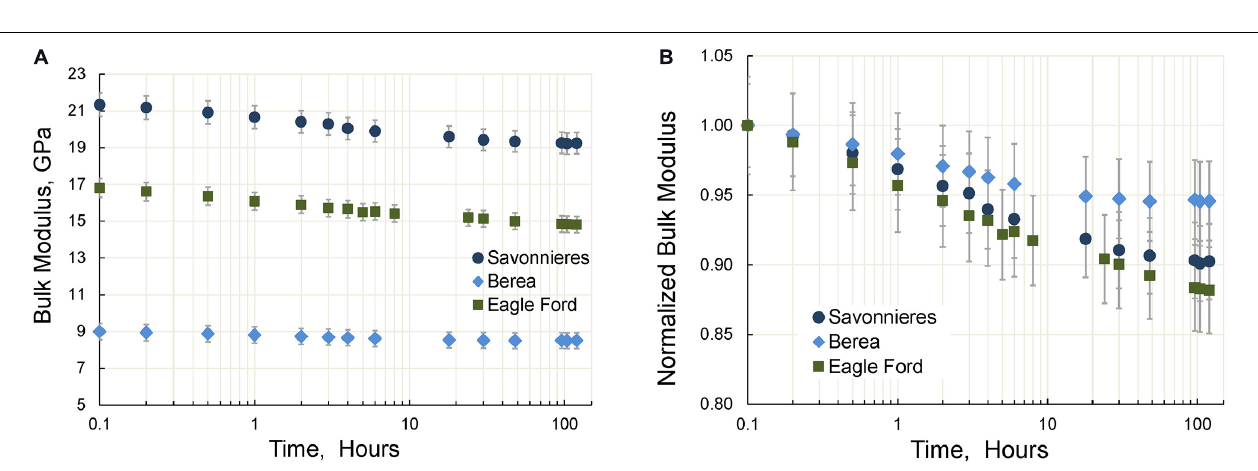
FIGURE 6 | The dependencies of the Young’s modulus (A) and Poisson ratio (B) on time measured for three rock samples. The measurements are conducted at a uniaxial pressure of 10 MPa.